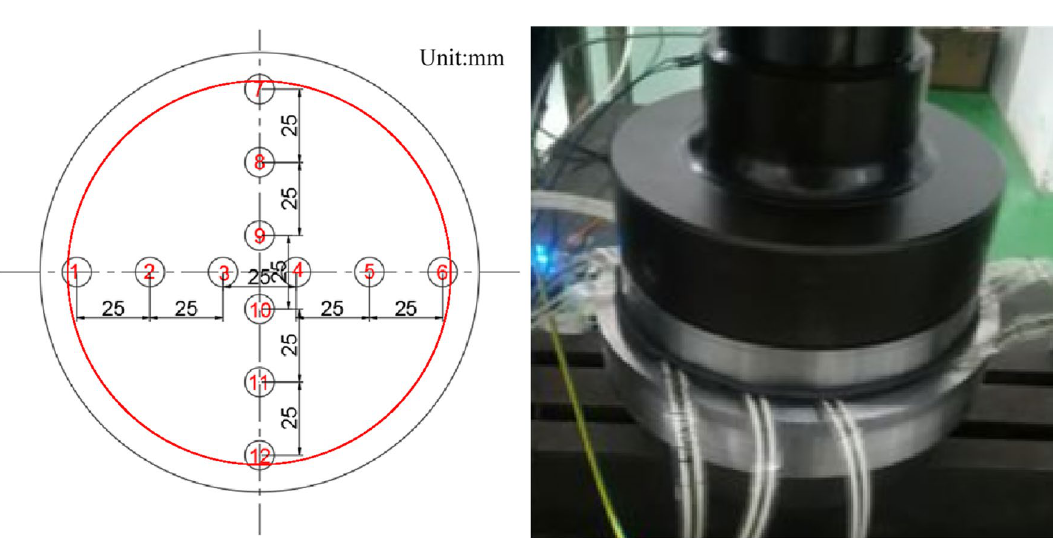
Figure 15. Sensor layout scheme and physical drawing of axial